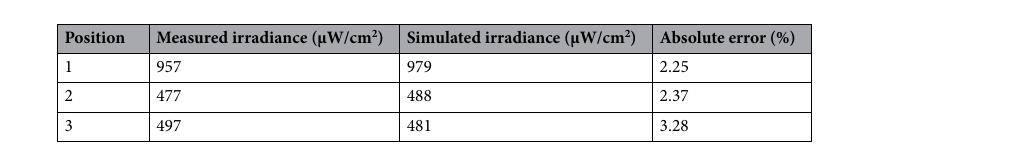
Table 3. Fitting of simulated to measured